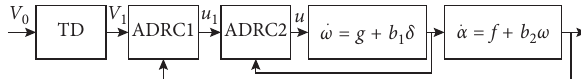
Figure 1: Basic structure of the double-loop cascade